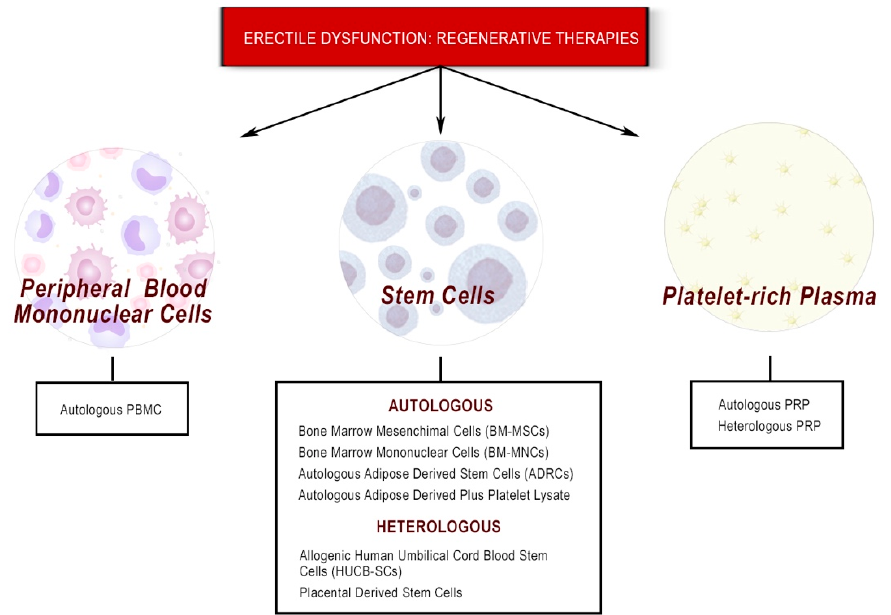
Figure 2. Summary of new regenerative medicine therapies available for the treatment of erectile dysfunction.